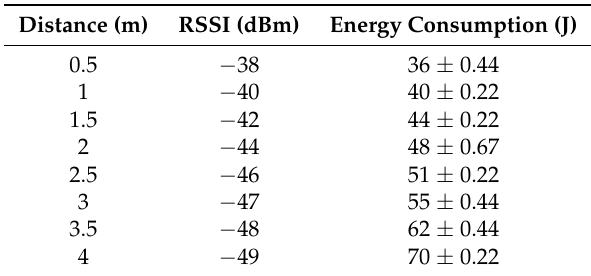
Table 1. Distance, RSSI and energy consumption in 30